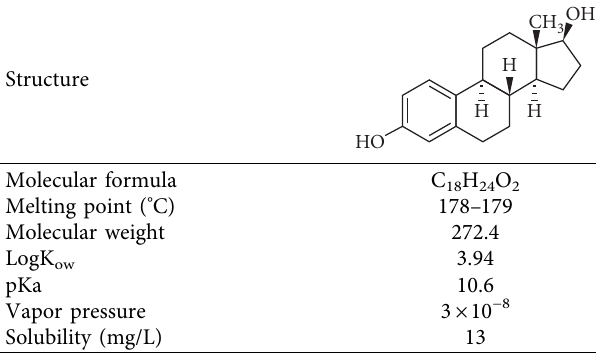
Table 1: Characteristics of